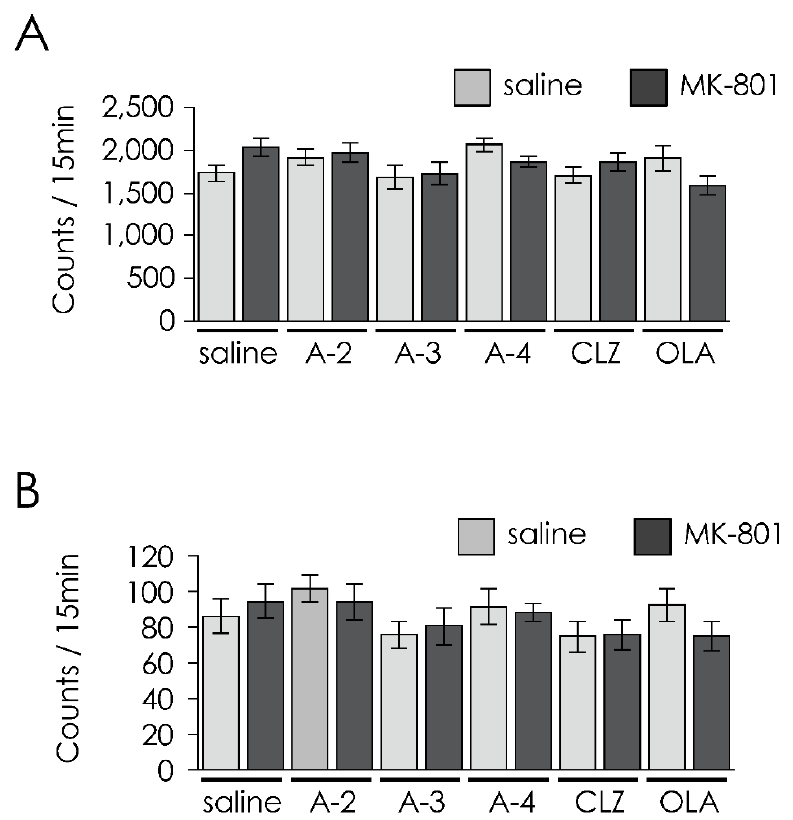
Figure 3. Effect of 14-day (PD 43–56) treatment with apocynin-tandospirone derivatives and antipsy- chotics on spontaneous ( A ) locomotor activity and ( B ) vertical activity (for 15 min after placed in the test chamber) on PD 57. Saline-saline group ( n = 12), MK801-saline group ( n = 12), saline-A2 group ( n = 12), MK801-A2 group ( n = 13), saline-A3 group ( n = 12), MK801-A3 group ( n = 12), saline-A4 group ( n = 13), MK801-A4 group ( n = 13), saline-CLZ group ( n = 12), MK801-CLZ group ( n = 12), saline-OLA group ( n = 12), and MK801-OLA group ( n = 12). Values are expressed as means ±